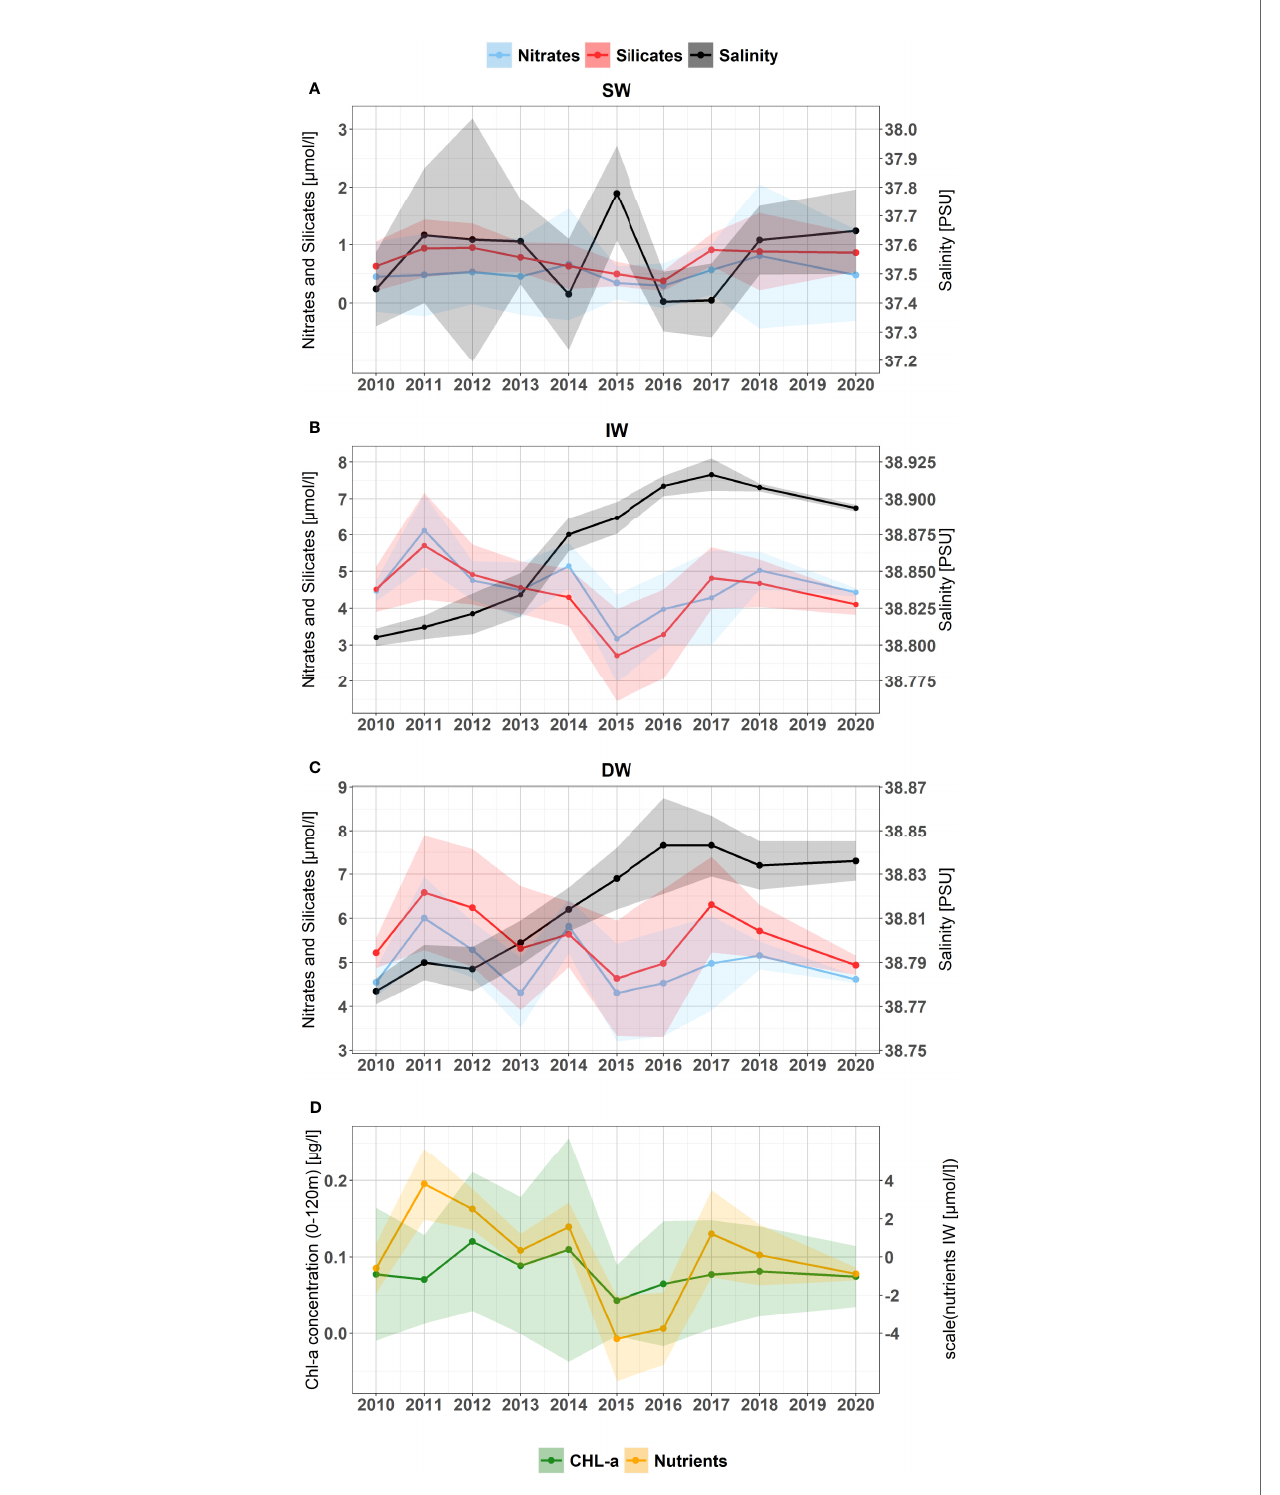
FIGURE 5 | The nitrates (blue line) and silicates (red line) time series was computed from the sum of the nitrates and silicates average concentrations within each layer (A) SW_0-100m, (B) IW_200-500m and (C) DW_500-bottom, for each year, in all sampling stations. In addition is reported the salinity time series (black line) described in Figure 3. (D) The Chl-a (green line) time series 2010-2020 was computed from the Chl-a average concentrations within each layer 0-120m depth. The related colored areas represent the standard